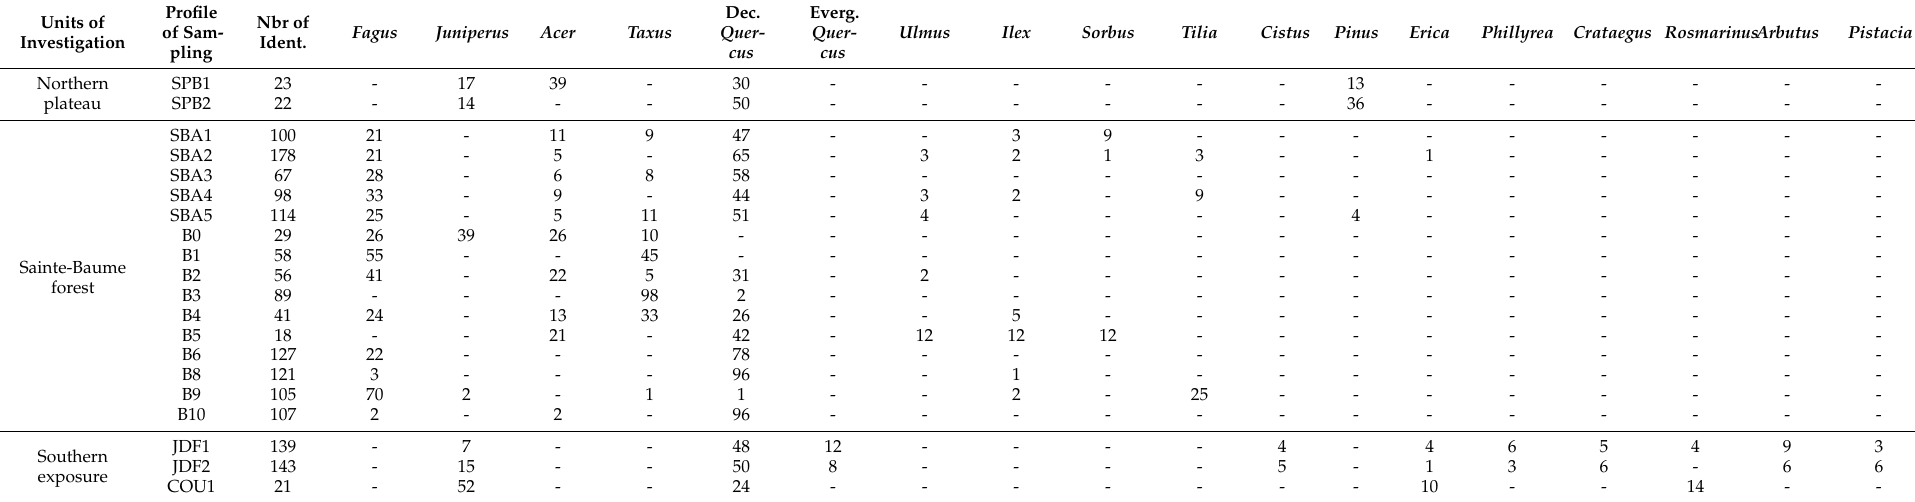
Table 2. Frequencies of identified taxa in the charcoal assemblages per sampled soil